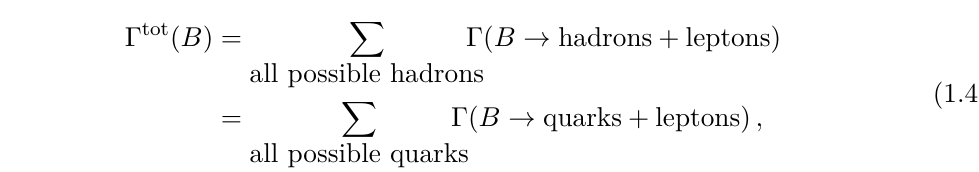
Table 2 . HFLAV averages of the experimental determinations of b -baryon lifetime ratios [57]. of a B -hadron, we can